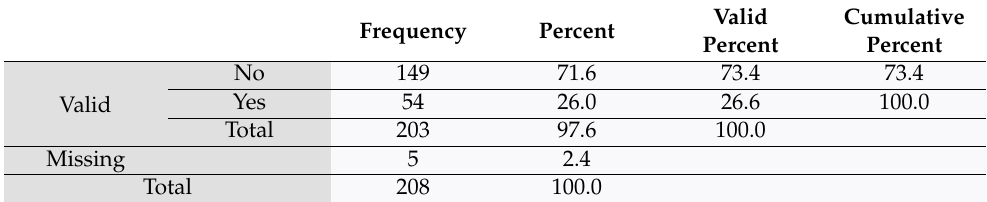
Table 3. Did you get infected with COVID-19?